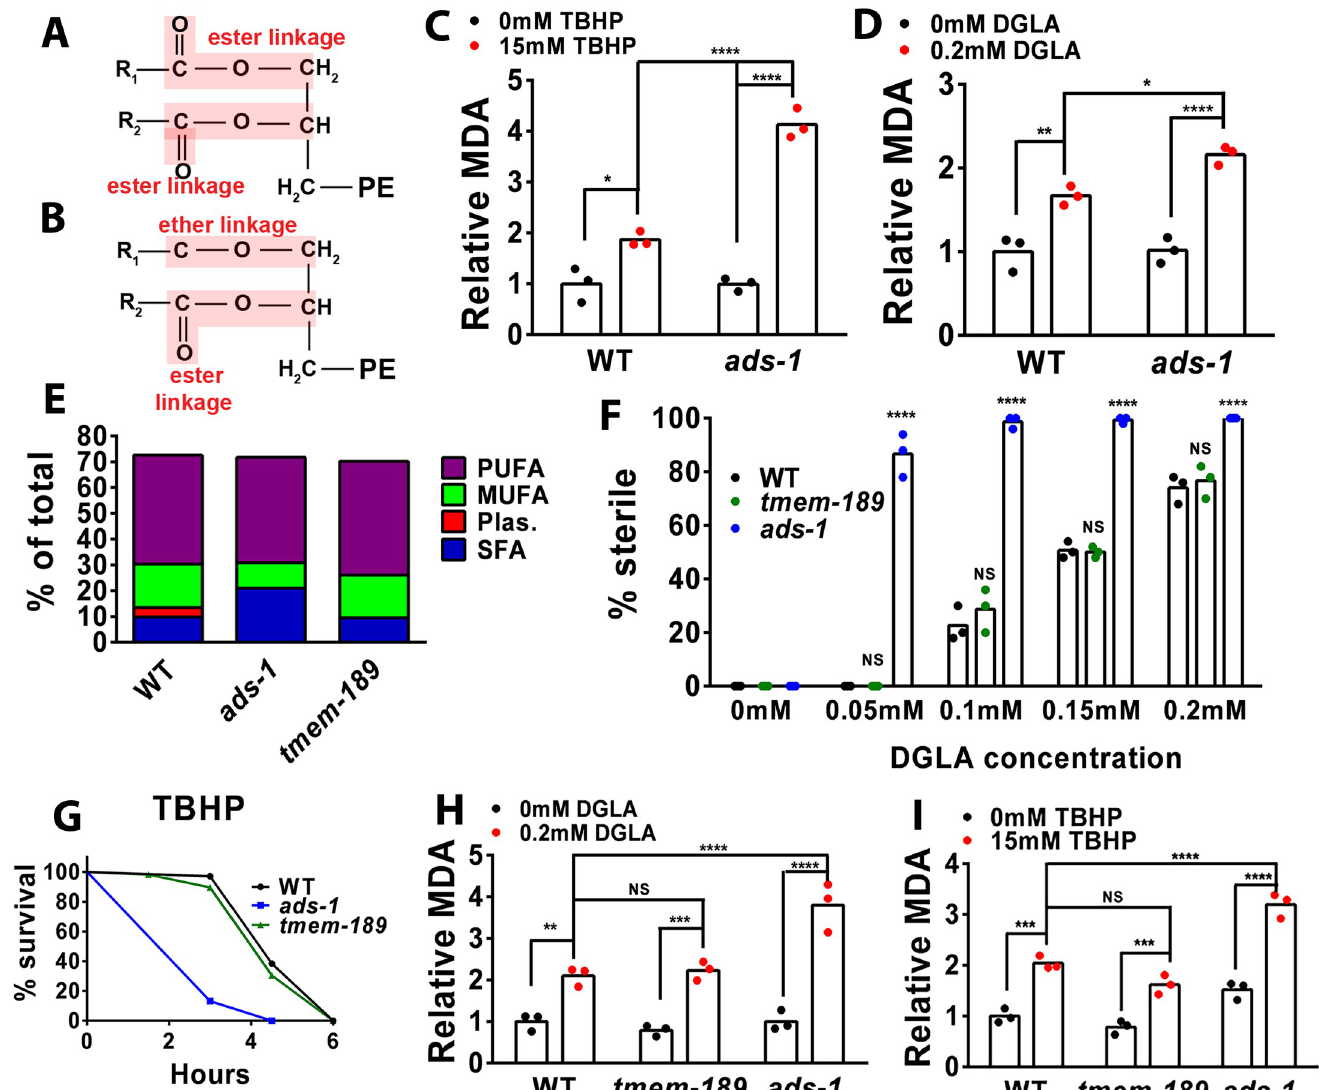
Fig 1. Plasmalogens are not required for protection in DGLA-induced ferroptosis or peroxide-induced oxidative stress. (A and B) structures of a typical phospholipid with two ester-linked fatty acids (A) or an “ether lipid”, with one ether linked fatty acid and one ester linked fatty acid (B). (C,D, H and I) Young adult worms were harvested and the end-product of lipid peroxidation, malondialdehyde (MDA), was measured and normalized to total protein using BCA. Each data point represents an independent experiment of 1,250 worms for each treatment. Statistical significance was determined using a two-way ANOVA with Tukey’s test for multiple comparisons summarized in S2 Table. TBHP, tert-butyl hydroperoxide; DGLA, dihommo-gamma-linolenic acid. (E) Simplified fatty acid composition in wild type, ads-1 , and tmem-189 . Detailed fatty acid composition of each strain with averages and standard deviations in S1 Table. PUFA, polyunsaturated fatty acid; MUFA, monounsaturated fatty acid; Plas, plasmalogen; SFA, saturated fatty acid. (F) Percentage (%) sterility in wild type, ads-1 , and tmem-189 raised on 0.05mM, 0.1mM, 0.15mM, and 0.2mM DGLA. Each data point represents an independent experiment of 50 worms for each treatment. Statistical significance was determined using a two-way ANOVA with Tukey’s test for multiple comparisons. Shown are the comparison of the mutant vs. WT, all comparisons are summarized in S2 Table. (G) Oxidative stress survival assays were performed with 14.7 mM TBHP. Wild type and ads-1 were used as controls to compare with the survival of tmem-189 . Approximately 100–200 worms were used for each strain per treatment. Statistical significance for survival was determined using log rank tests (Mantel Cox) and summarized in S2 Table. Fatty acid composition and sterility for (E, F and H) are displayed in S1 Table. Statistical differences shown are NS, not significant, � P < 0.05, �� P < 0.01, ��� P < 0.001, ���� P <